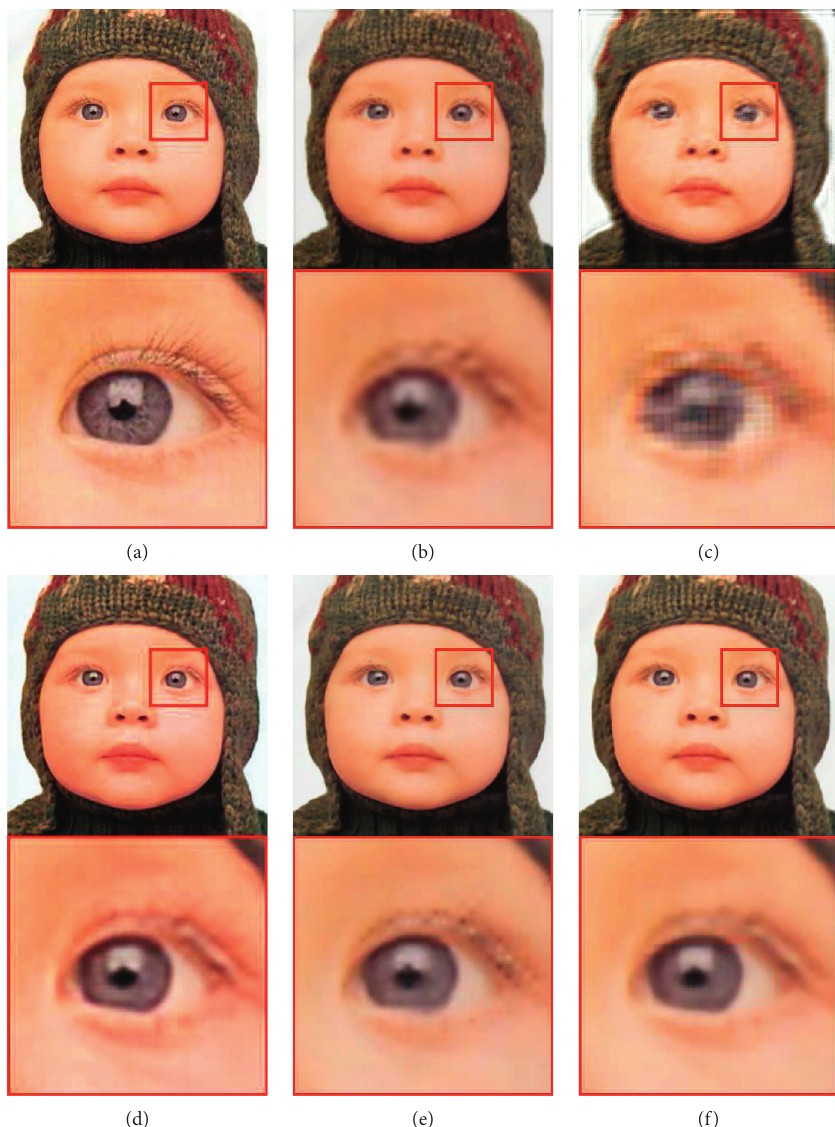
Figure 6: Super-resolution results of the “baby” image with magnification factor 4: (a) original high-resolution image; (b) result reconstructed by SRCNN; (c) result reconstructed by FSRCNN; (d) result reconstructed by SRGAN; (e) result reconstructed by RDN; (f) result reconstructed by our method.